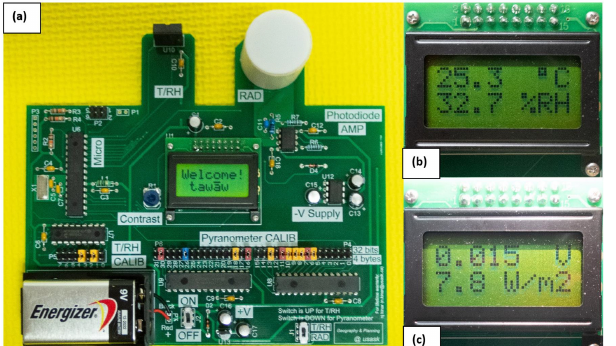
Figure 7. Water detection PCB. A droplet of water turns on the light-emitting diode (LED) and an attached piezoelectric buzzer to provide visual and audible feedback.